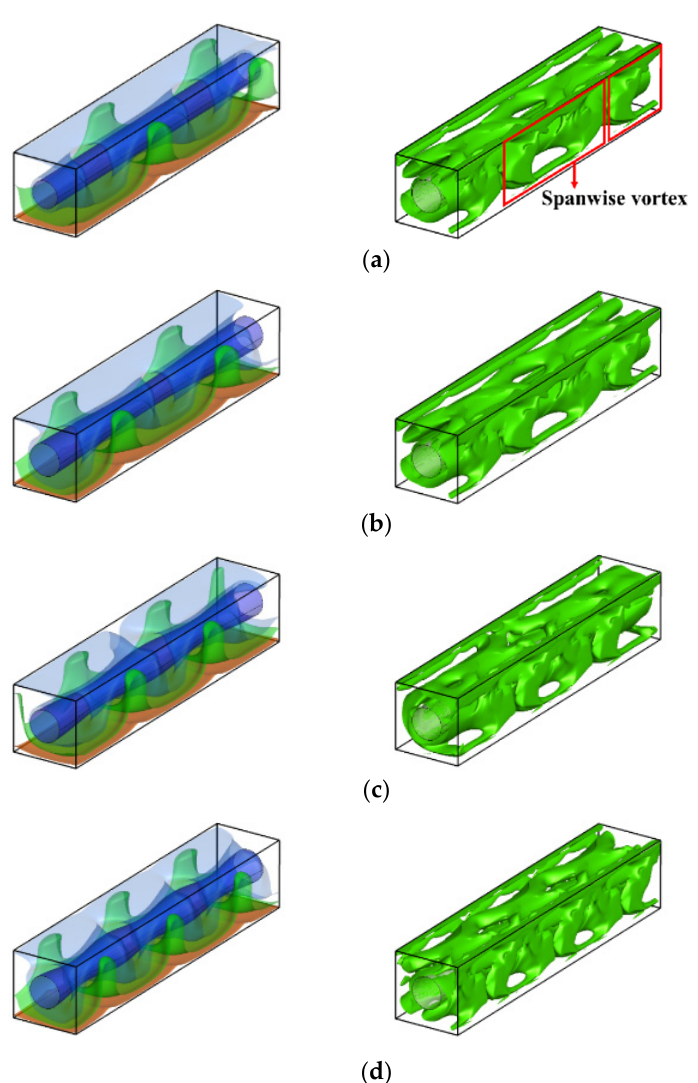
Figure 4. Distribution of temperature with θ = 0.1, 0.5, and 0.9 and vortical structure with λ 2 = − 0.1 as function of λ at Re = 100. ( a ) λ = 0; ( b ) λ = 1; ( c ) λ = 2; ( d ) λ =